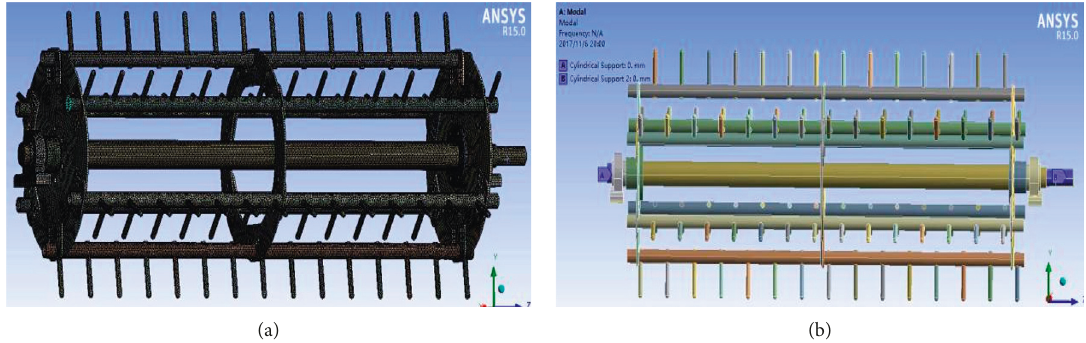
Figure 3: Preprocessing of finite element simulation. (a) Mesh model. (b) Restricted modality by bearing.